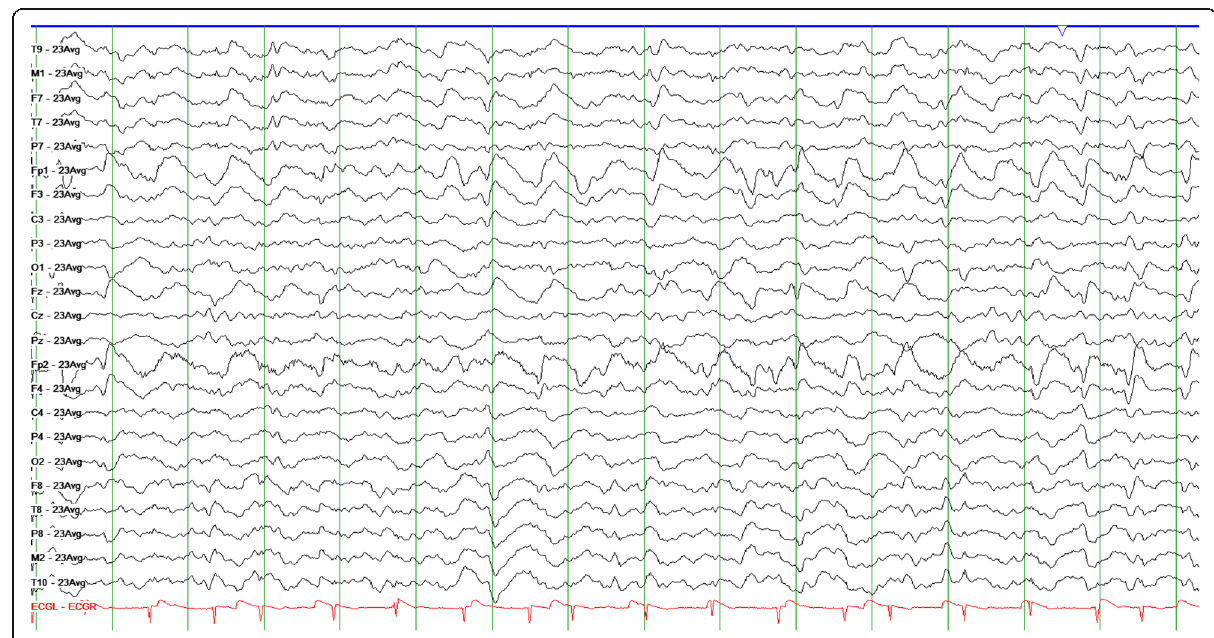
Fig. 4 Generalized rhythmic delta activity (GRDA) at a freqency of 0.5-1 Hz in a patient with metabolic derangement. High pass filter 1 Hz, low pas filter 50 Hz and sensitivity 10